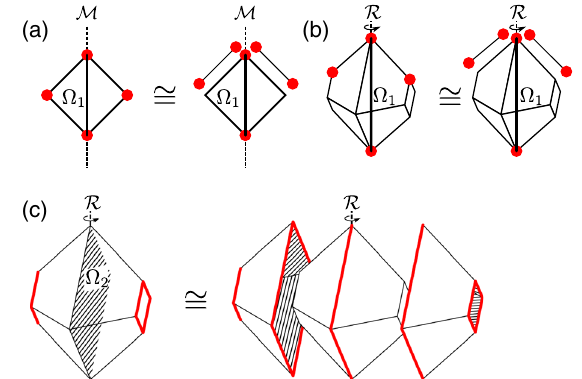
FIG. 4. By attaching a “ decoration ” consisting of a first-order topological phase on a boundary of codimension n − 1 , an arbitrary configuration of boundary state of codimension n can be moved to the subset ∂ Ω . The figure shows three d þ 1 − n examples: Corner states of a two-dimensional crystal with mirror symmetry ( n ¼ 2 ), which can always be moved to the inter- section of the mirror line and the crystal boundary upon changing the crystal termination (a), corner states of a three-dimensional crystal with twofold rotation symmetry ( n ¼ 3 ), which can always be moved to the intersection points of the twofold rotation axis and the crystal boundary upon changing the termination along crystal hinges (b), and hinge states of a three-dimensional crystal with twofold rotation symmetry, which can always be moved to the intersection of the two-dimensional manifold Ω 2 and the crystal boundary upon changing the termination at crystal faces